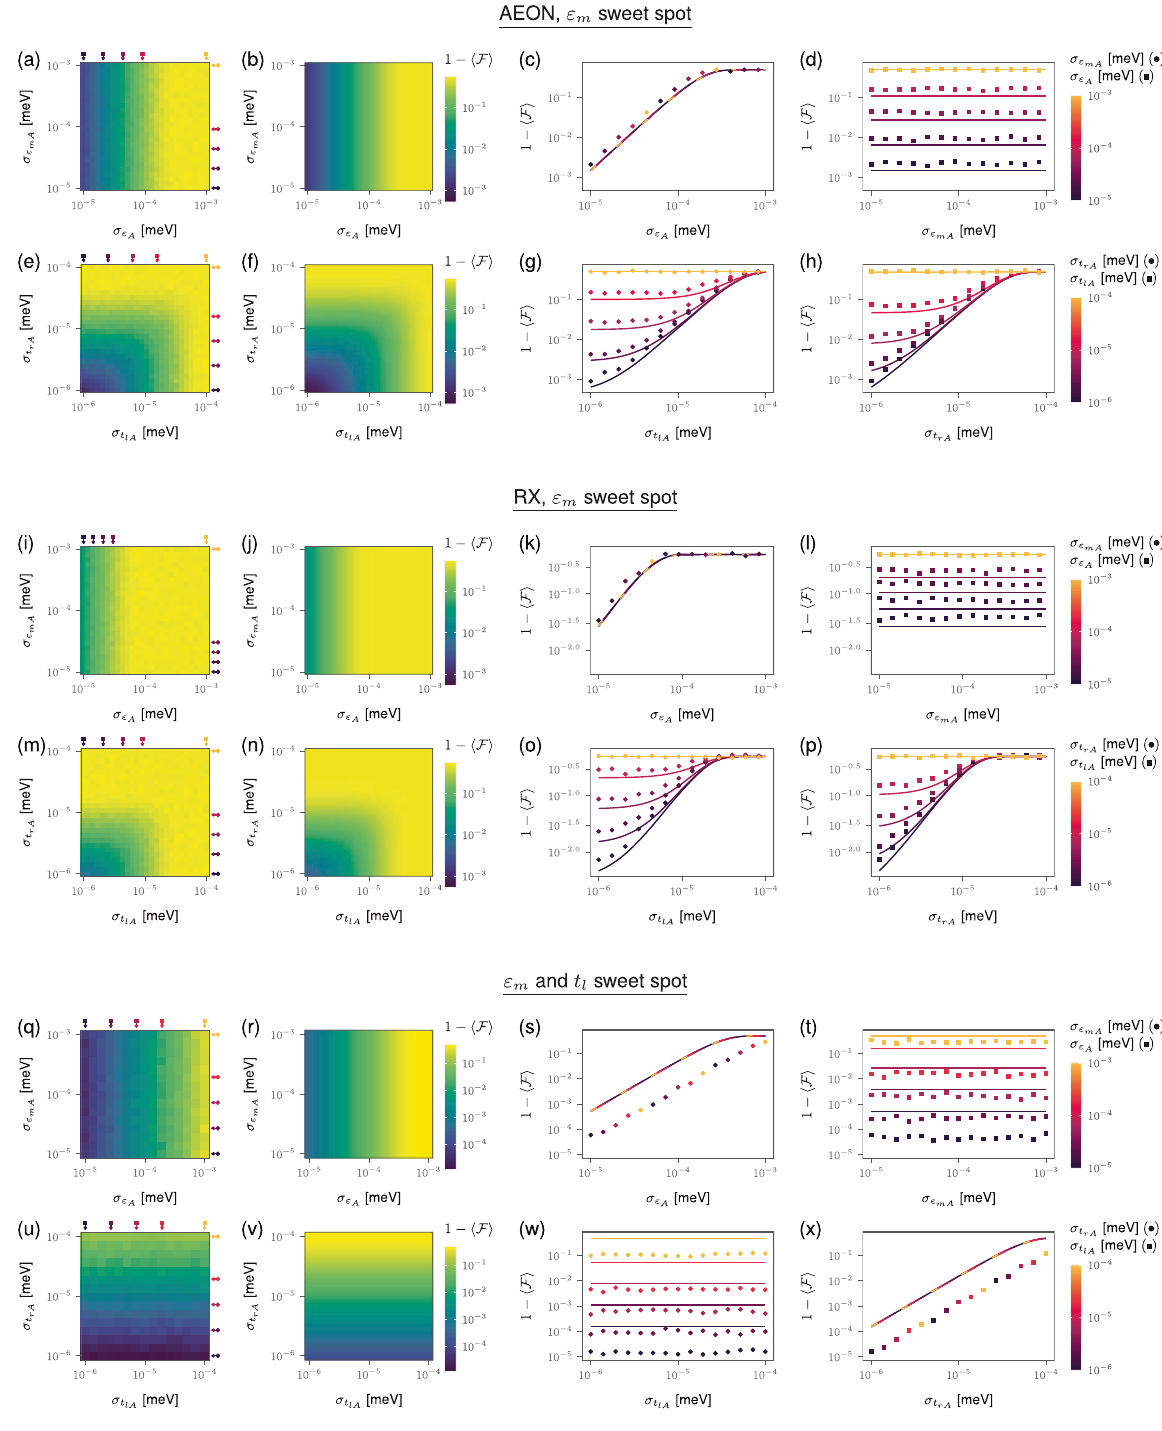
Supplementary Note 5). When comparing in fi delities from only detuning noise with that from only tunneling noise at the same working point, e.g., between panels (a, b) and (e, f), or between panels (i, j) and (m, n) of Fig. 3, it is clear that in fi delity is less sensitive to noise in detuning than tunneling. Now, we examine the case when the RX and AEON qubits are operated at ε m 2QSS and ε 1QSS. When arctan ð t lA = t rA Þ ¼ 57 (cid:7) , the